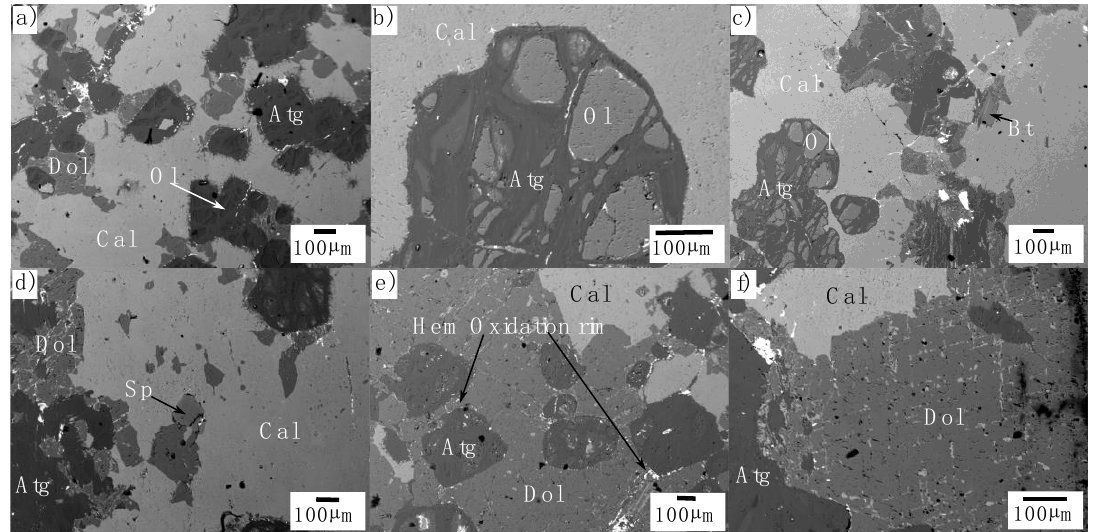
Figure 5. Back-Scattered Electron (BSE) images of an intermediate metasomatized sample, showing dolomite dissolution to form olivine, calcite, and serpentine ( a ); resorbed olivine grains within the serpentinized pods ( b ); biotite present along with the serpentinized olivine-bearing pods, calcite, and dolomite assemblage ( c ); euhedral spinel present along the dolomite and calcite contact ( d ); hematite forms as micrometer-sized grains dispersed along the grain boundaries of the serpentinized pods, as veins and as discrete grains ( e ); replacement calcite precipitation along the cleavage planes of dolomite grains ( f ). Bt—Biotite; Ilm—Ilmenite; Pl—Plagioclase; Amph—Amphibole; Atg—Antigorite; Ol—Olivine; Cal—Calcite; Dol—Dolomite; Sp—Spinel.